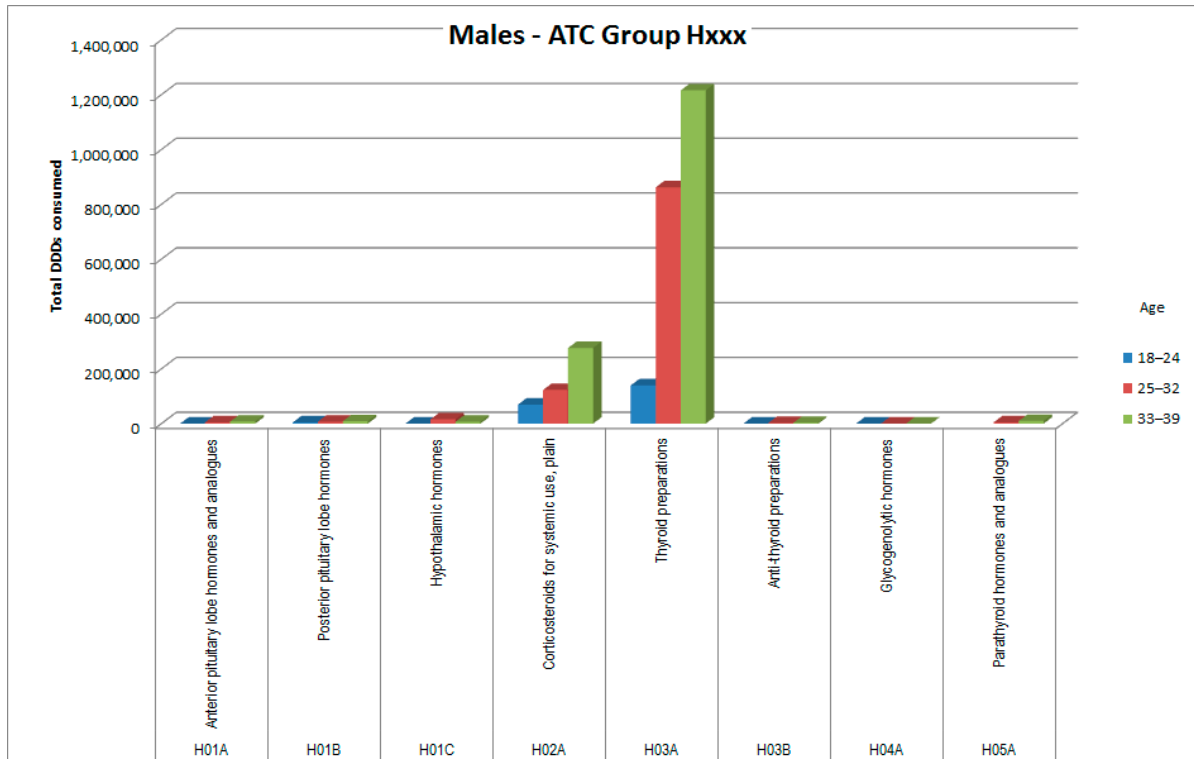
Healthcare 2021 , 9 , x Figure 11. DDD consumption for females, ATC group Hxxx. Figure 11. DDD consumption for females, ATC group Hxxx.